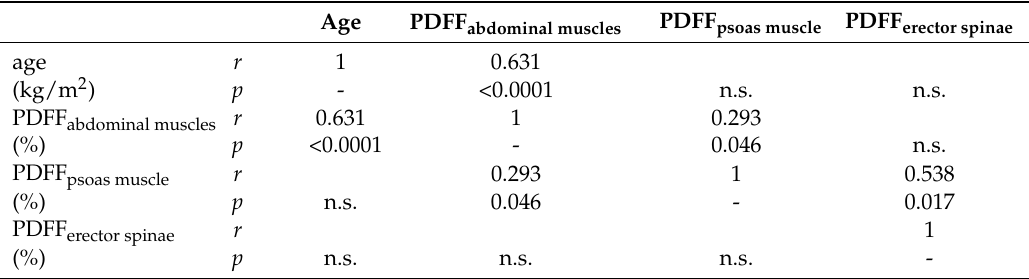
Table 8. Partial correlations for women with BMI as a control